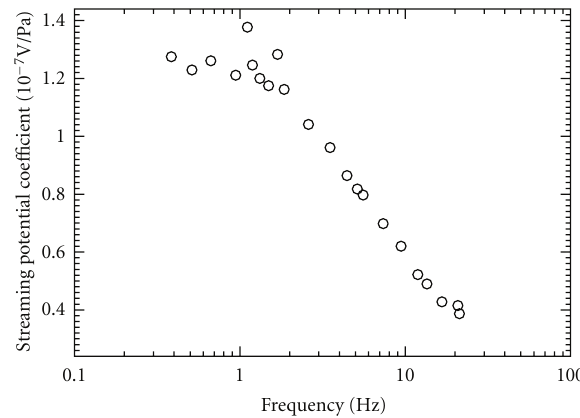
Figure 7: The absolute magnitude of the normalized streaming potential coe ffi cient calculated by Packard [59] using (19) where (cid:7) a ωρ /η , equivalent to (2) (modified from [59]). Y a = f